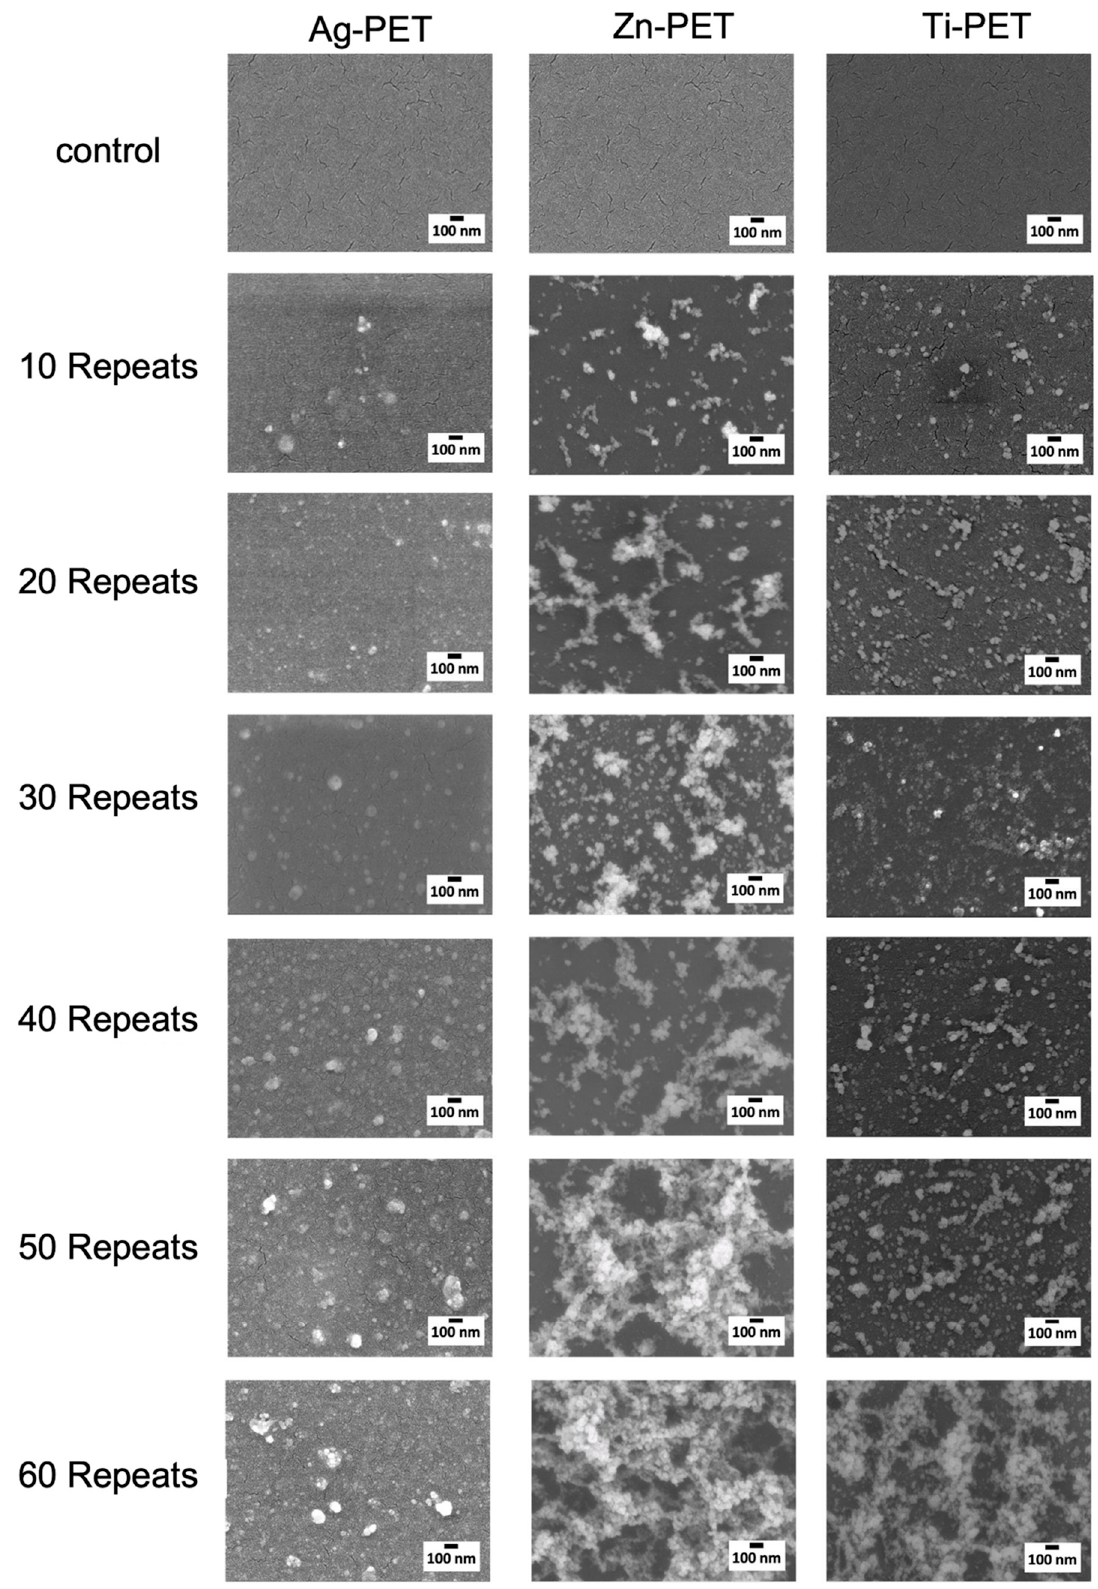
Figure 2. Scanning electron microscope (SEM) images of the Ag-PET, Zn-PET, and Ti-PET films repeated 0–60 times.